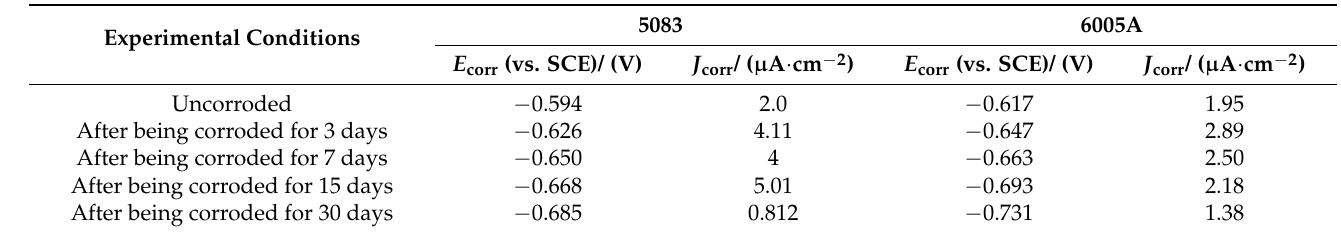
Table 3. Test results of polarization curves in different environments for the 5083/6005A welded joints.